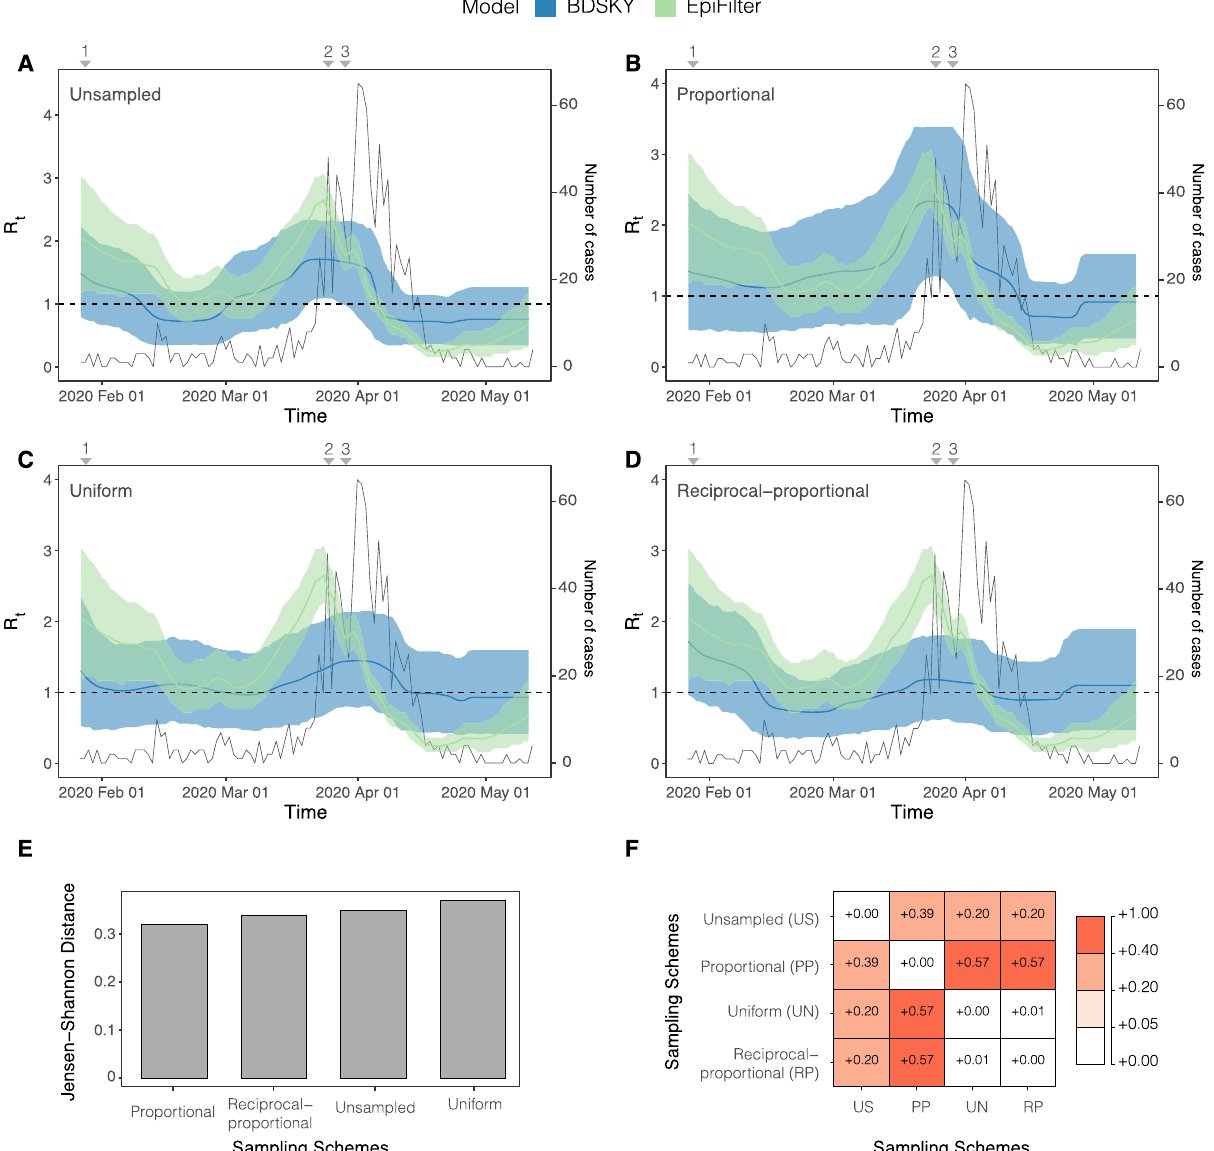
Fig. 4 | R t estimated from both the Birth Death Skyline (BDSKY) and EpiFilter methodsforHongKong. Titlesindicatethesamplingschemeusedinpanels A – D . The light-shaded area represents the 95% highest posterior density interval. The solidlinerepresentsthemean R t estimatewith EpiFilter ingreenandBDSKYinblue. Theblacklineplotsthenumberofcases.WerefertoFig.1forabriefdescriptionof